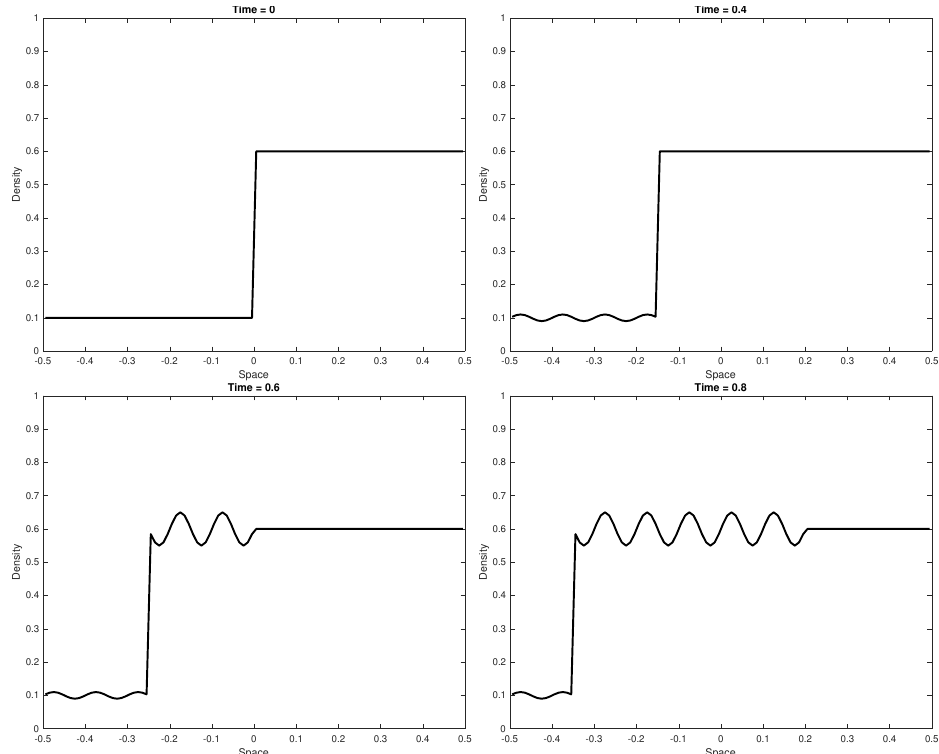
Figure 5. Evolution of the density for our model on a single